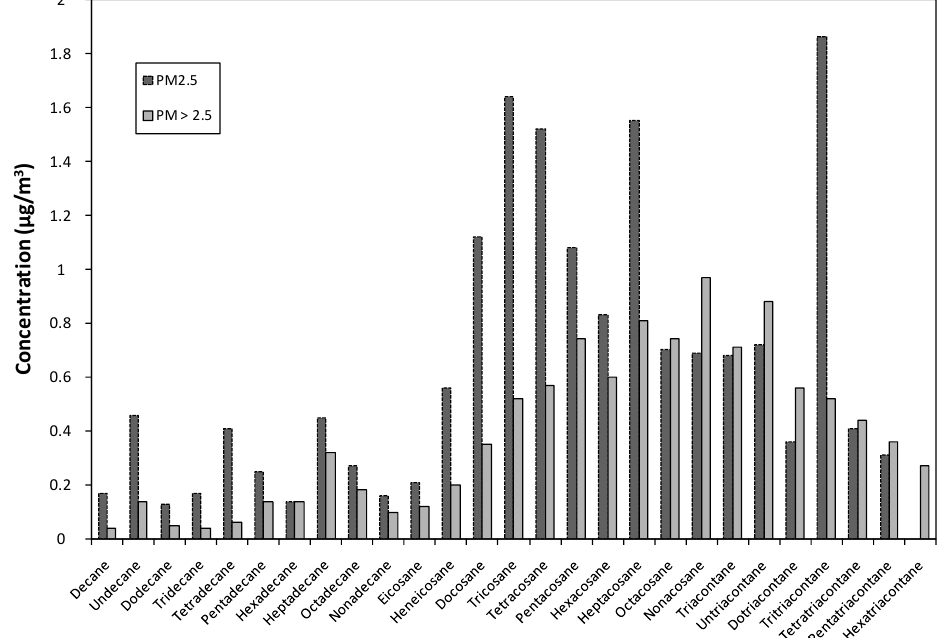
Figure 4. Paraffins concentrations in the two air particulate matter.